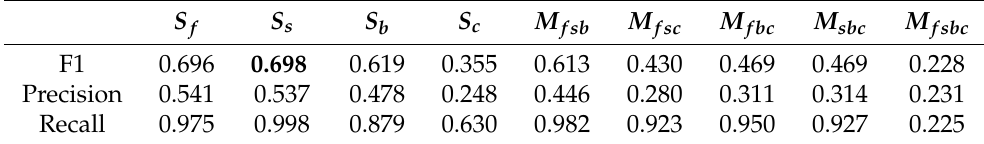
Table 6. Performance of inducible emotion recognition of Driver A.